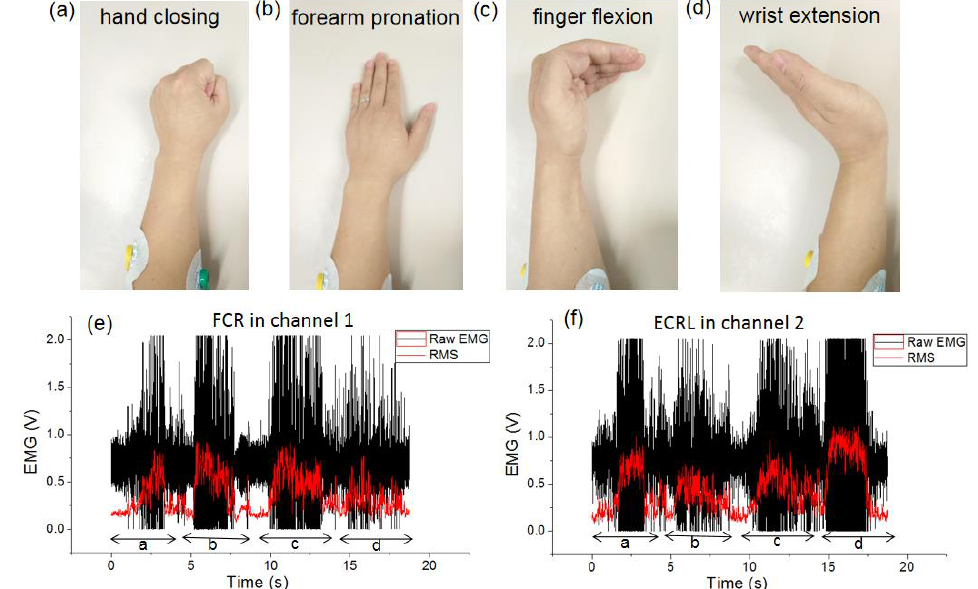
Figure 9. Segmentation process of EMG with two-channel monitoring in the FCR and the ECRL